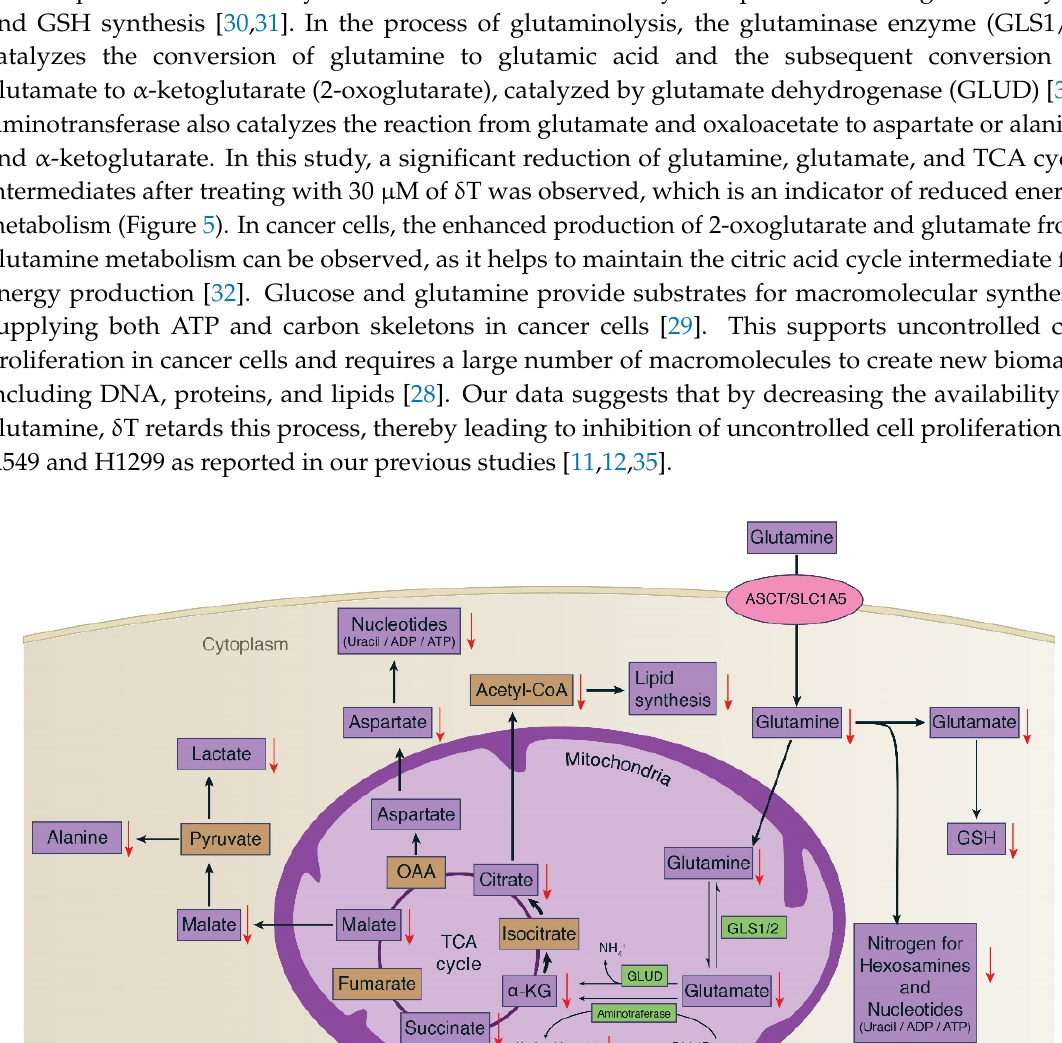
metabolite concentrations determined using Chenomx NMR Suite in A549 cells. Table S2: List of metabolite concentrations determined using Chenomx NMR Suite in H1299 cells. Figure S1: Effects of δT on A549 (A) and H1299 (B) on the metabolome of lung cancer cell lines.